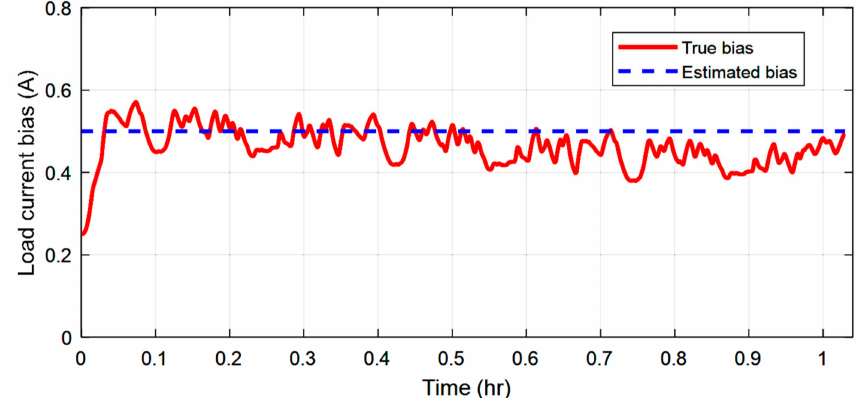
Figure 12. The current bias estimation of current through LiBP.